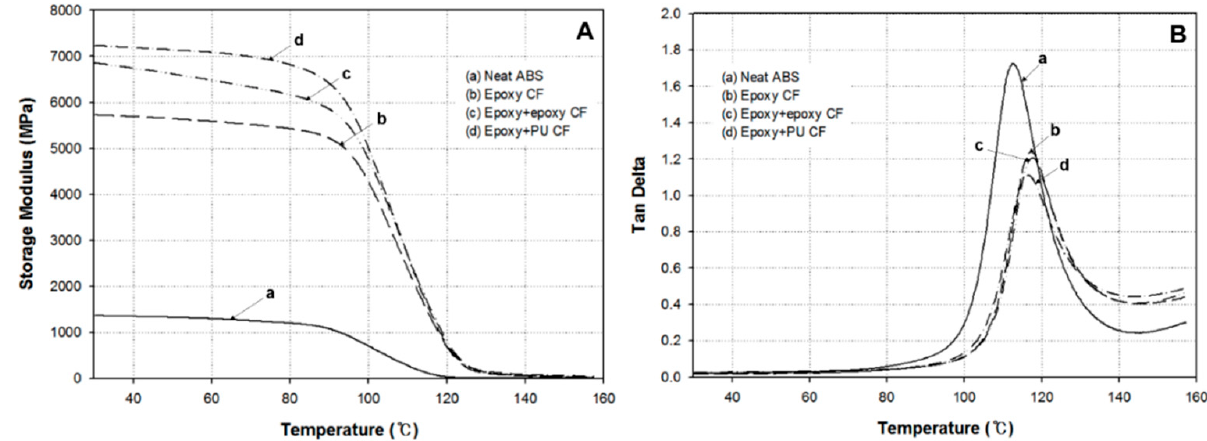
Figure 7. Variations of the ( A ) storage modulus and ( B ) tan δ of neat ABS and carbon fiber/ABS composites with (epoxy) single-sized and (epoxy + epoxy, epoxy + PU) dual-sized carbon fibers.